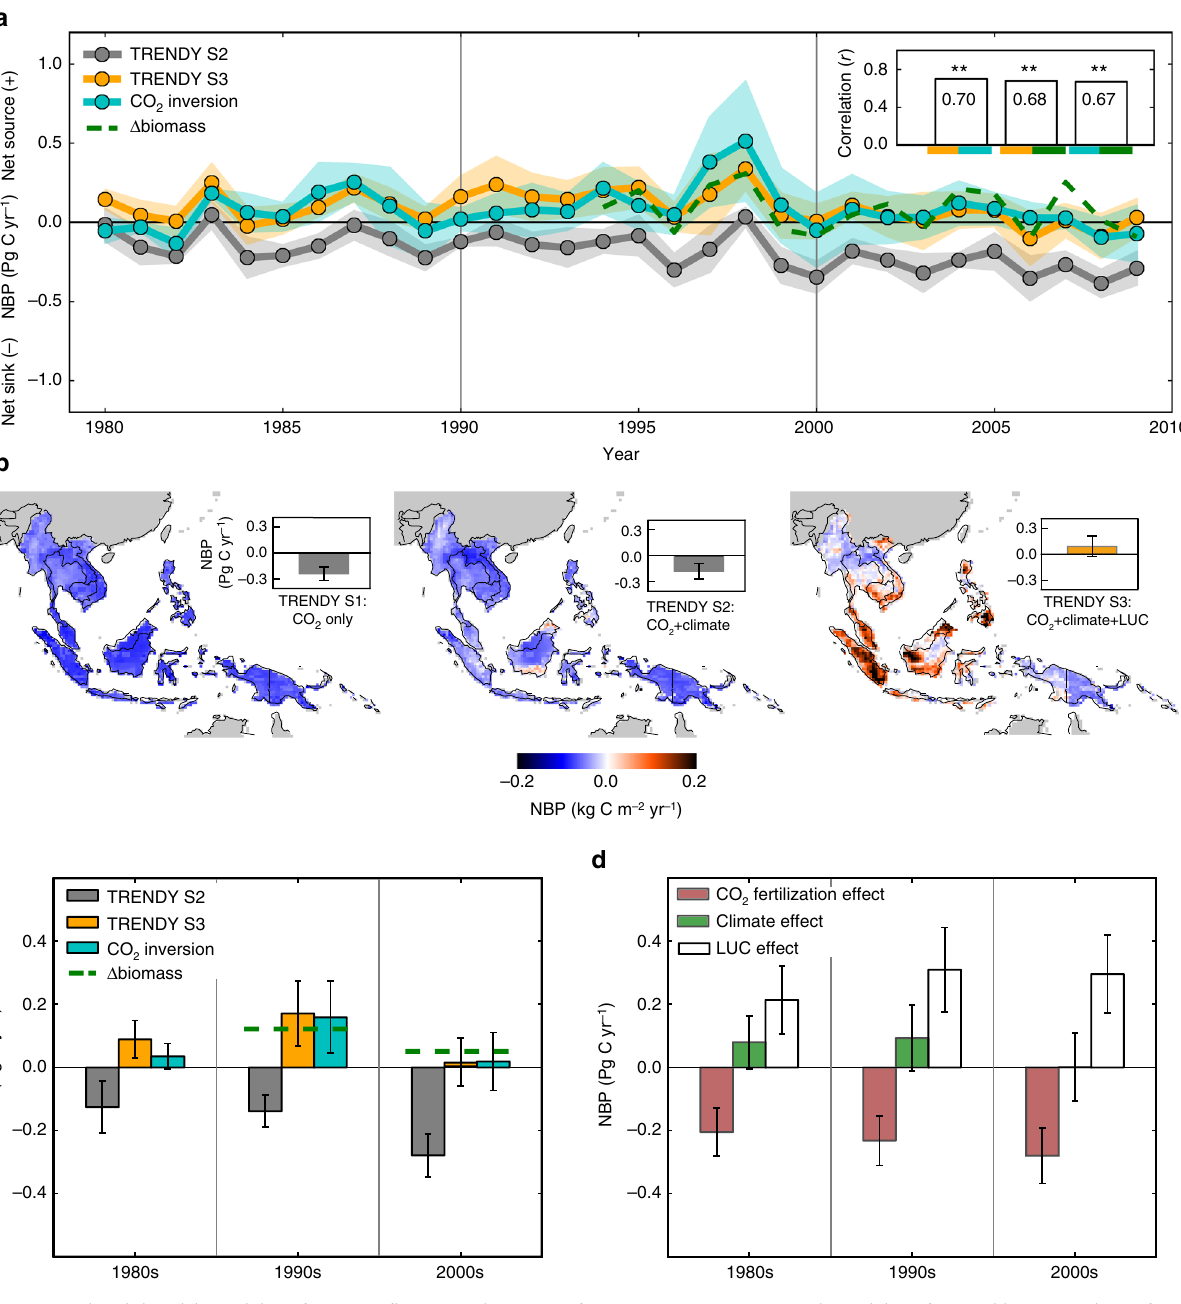
Fig. 1 Interannual and decadal variability of net CO 2 fl ux in Southeast Asia for 1980 – 2009. a Interannual variability of ensemble averaged NBP from the TRENDY (grey: TRENDY S2; orange: TRENDY S3) and atmospheric CO 2 inversions (cyan) for the period 1980 – 2009, and annual biomass change (dashed green line: Δ biomass) for the period 1994 – 2009. Shading for the TRENDY and atmospheric CO 2 inversions represents 1 σ variation among models. A top- right panel shows correlation coef fi cients ( r ) between interannual variability of the three NBP estimates for the overlapping periods (1980 – 2009 for the TRENDY and atmospheric CO 2 inversions; 1994 – 2009 for the TRENDY and Δ biomass, and for the atmospheric CO 2 inversions and Δ biomass) and statistical signi fi cance is indicated by ** p < 0.01. Negative values in NBP represent a net sink, and positive values a net source. b Spatial variability of mean annual NBP from the TRENDY (seven model ensemble average) for the period 1980 – 2009. Results are shown for the three simulations: forced with varying CO 2 only (left: TRENDY S1); varying CO 2 and climate (middle: TRENDY S2); and varying CO 2 , climate and LUC (right: TRENDY S3). Bar graphs represent mean annual NBP by the TRENDY simulations (grey: TRENDY S1 and S2; orange: TRENDY S3) for the period 1980 – 2009 with error bars representing 1 σ variation among models. c Decadal NBP budgets from the TRENDY (grey: TRENDY S2; orange: TRENDY S3) and atmospheric CO 2 inversions (cyan) for the 1980s, 1990s and 2000s, with error bars representing 1 σ variation among models. Decadal budgets from annual biomass changes are shown with dashed horizontal lines for the 1990s (1994 – 1999) and 2000s (2000 – 2009). d Decadal variability of the attributing factors to NBP from the TRENDY (crimson: the CO 2 fertilization effect, green: the climate effect and white: the LUC effect) with error bars representing 1 σ variation among